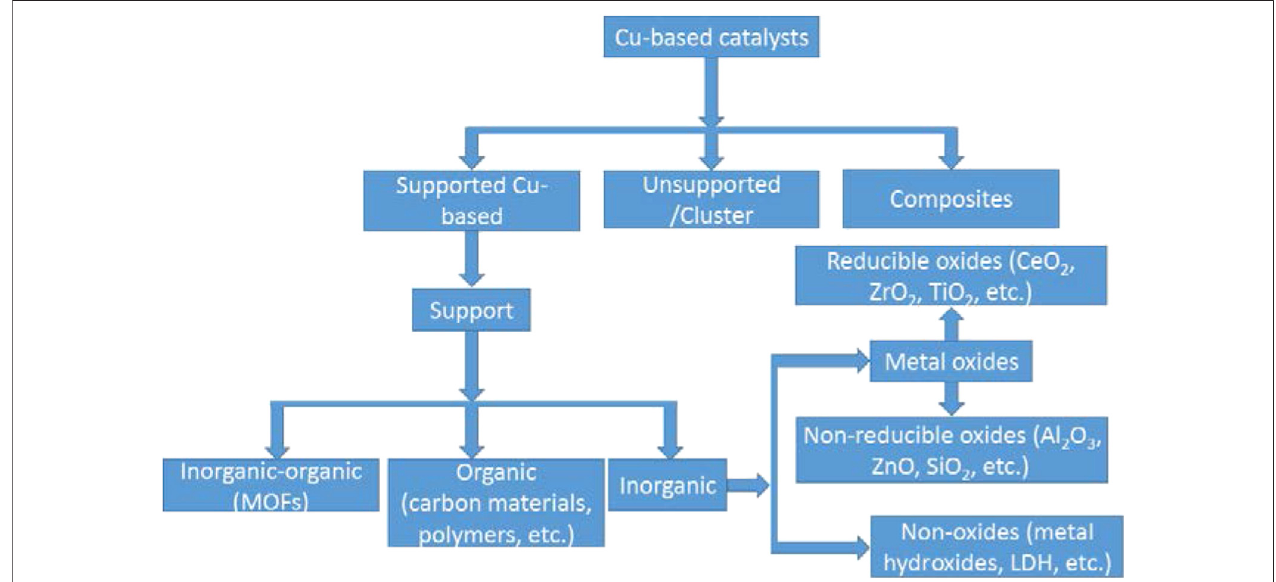
FIGURE 10 | Classi fi cation of supports for Cu-based methanol synthesis